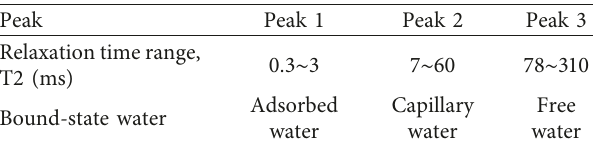
Table 4: Relaxation time range of Peak 1, Peak 2, and Peak 3 and the corresponding bound state